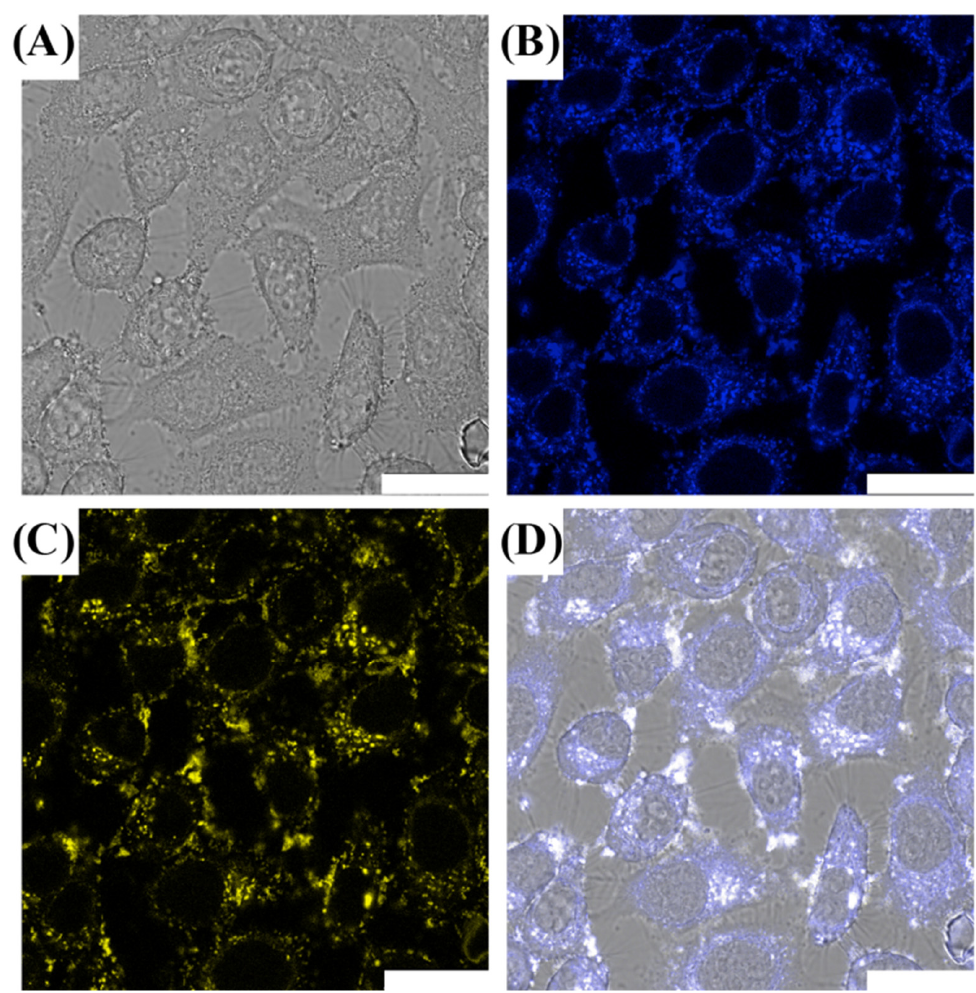
Figure 4. Laser scanning confocal microscopy images of PEG-CDs@PEI incubated with HeLa cells for 24 h. The cells were observed ( A ) under bright field; ( B ) excited at 405 nm; ( C ) excited at 488 nm; ( D ) overlapped images of B and C (scale bar = 25 μ m).